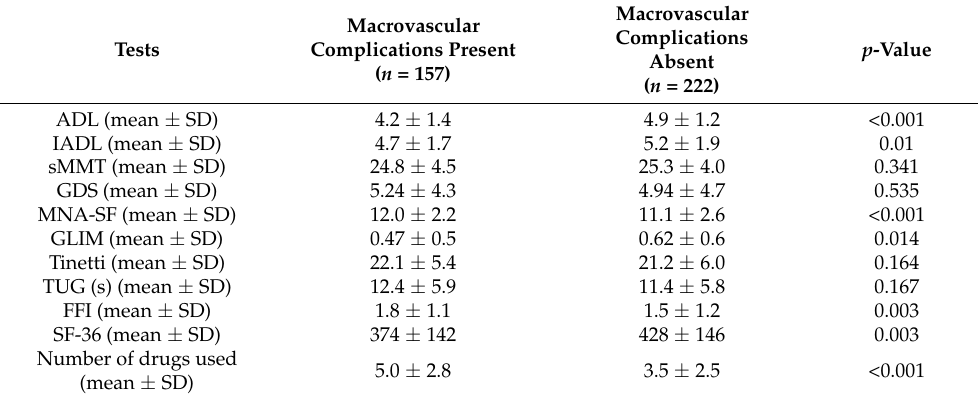
Table 2. Results of comprehensive geriatric assessment, frailty, and QOL